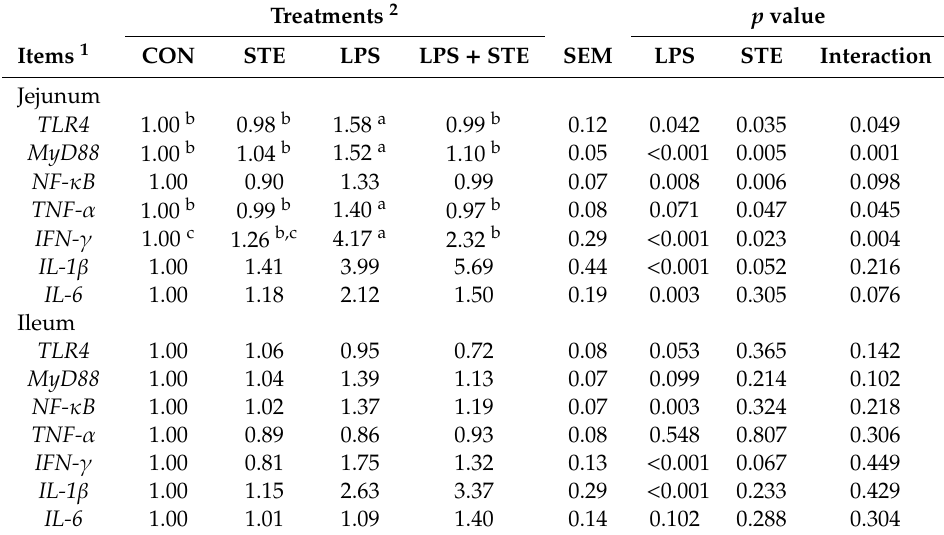
Table 5. E ff ects of stevioside supplementation on inflammatory gene expression in the intestinal mucosae of LPS-challenged